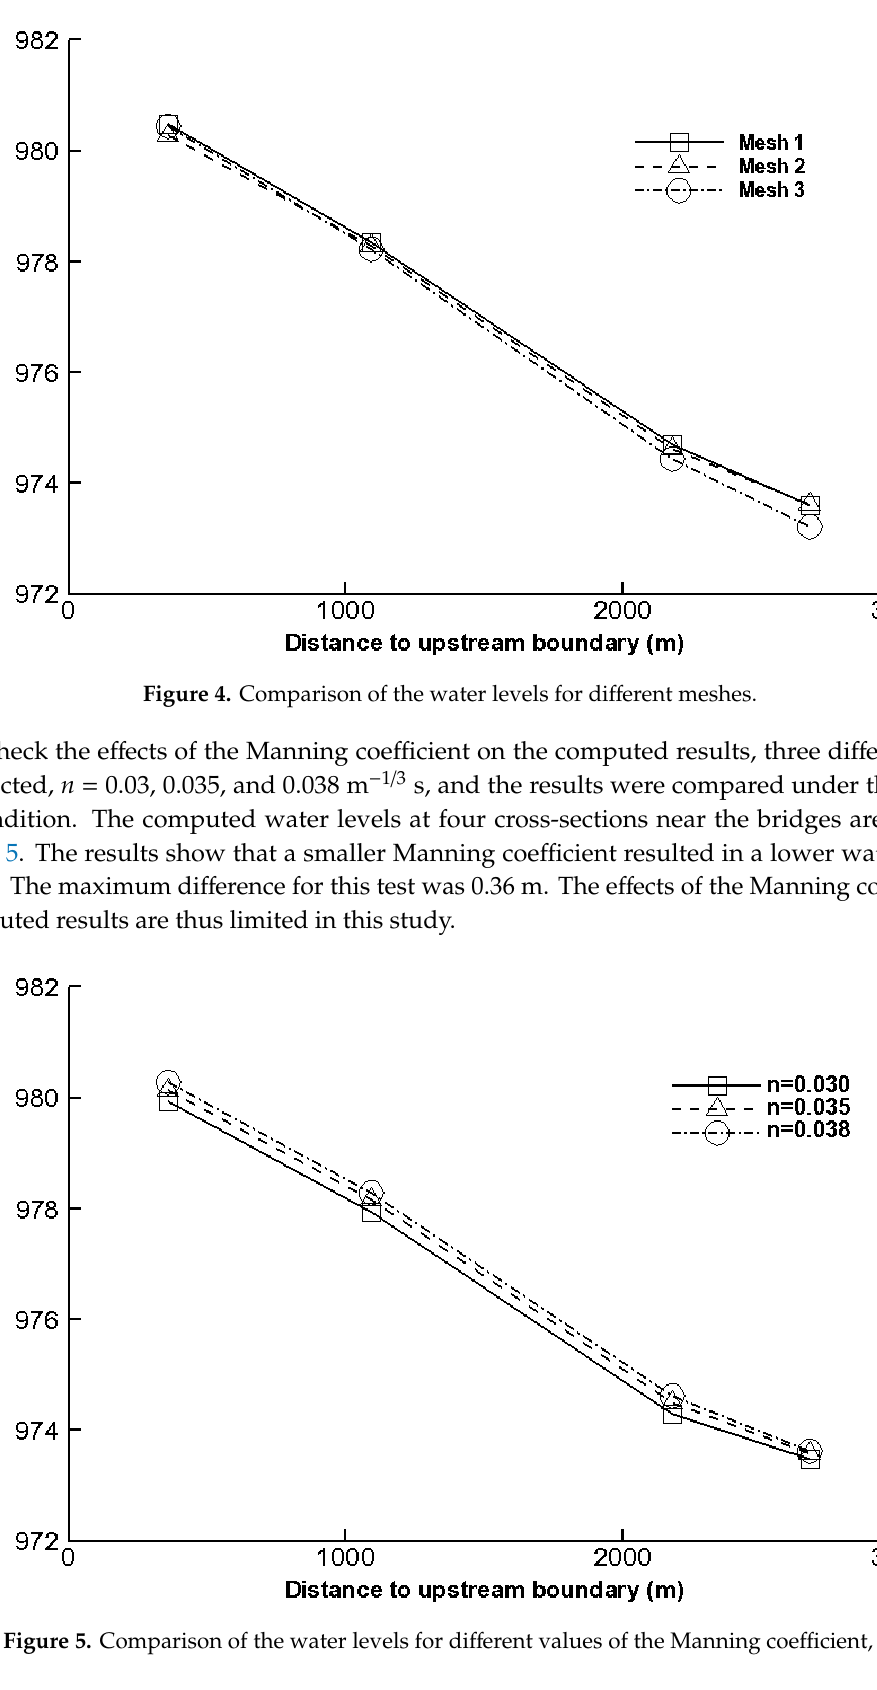
Table 1. Setup for the three sets of meshes.